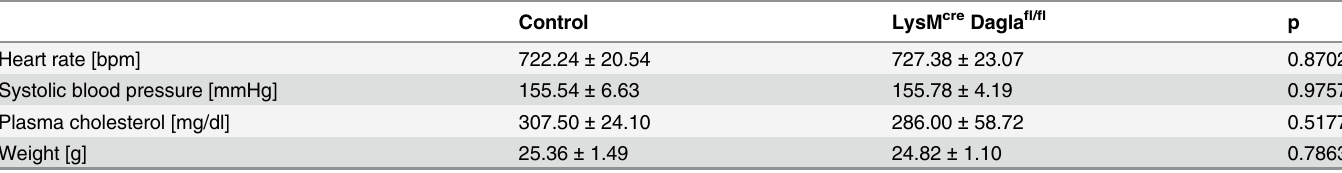
Table 1. Heart rate, blood pressure, cholesterol,